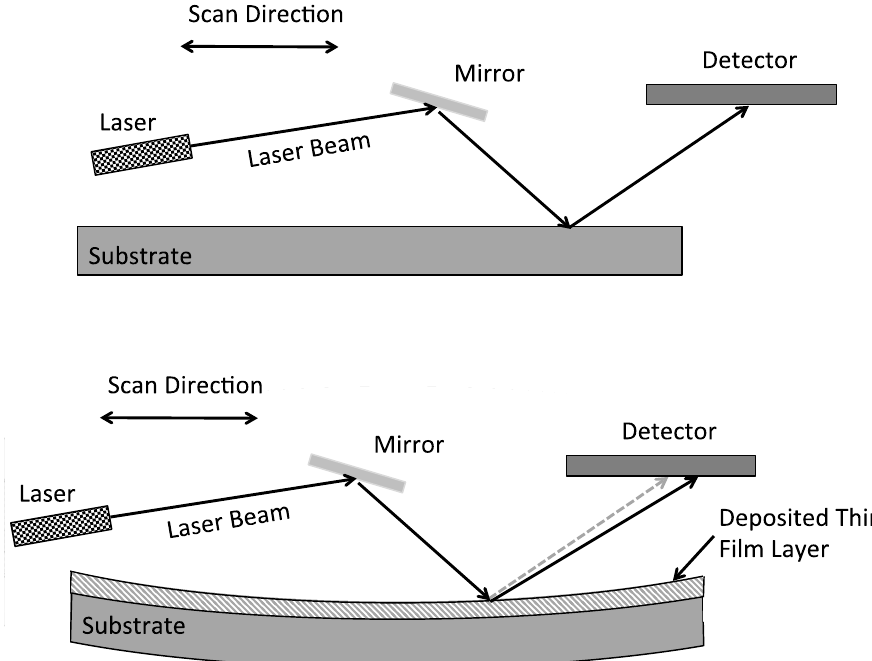
Figure 5. Illustration on the operation of the wafer curvature metrology tool.